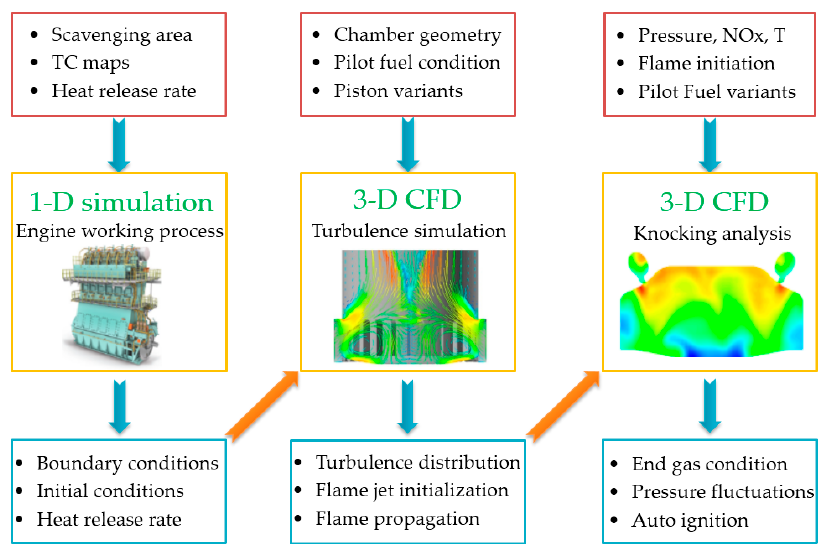
Figure 1. Simulation model of a 6RT-Flex50DF engine.